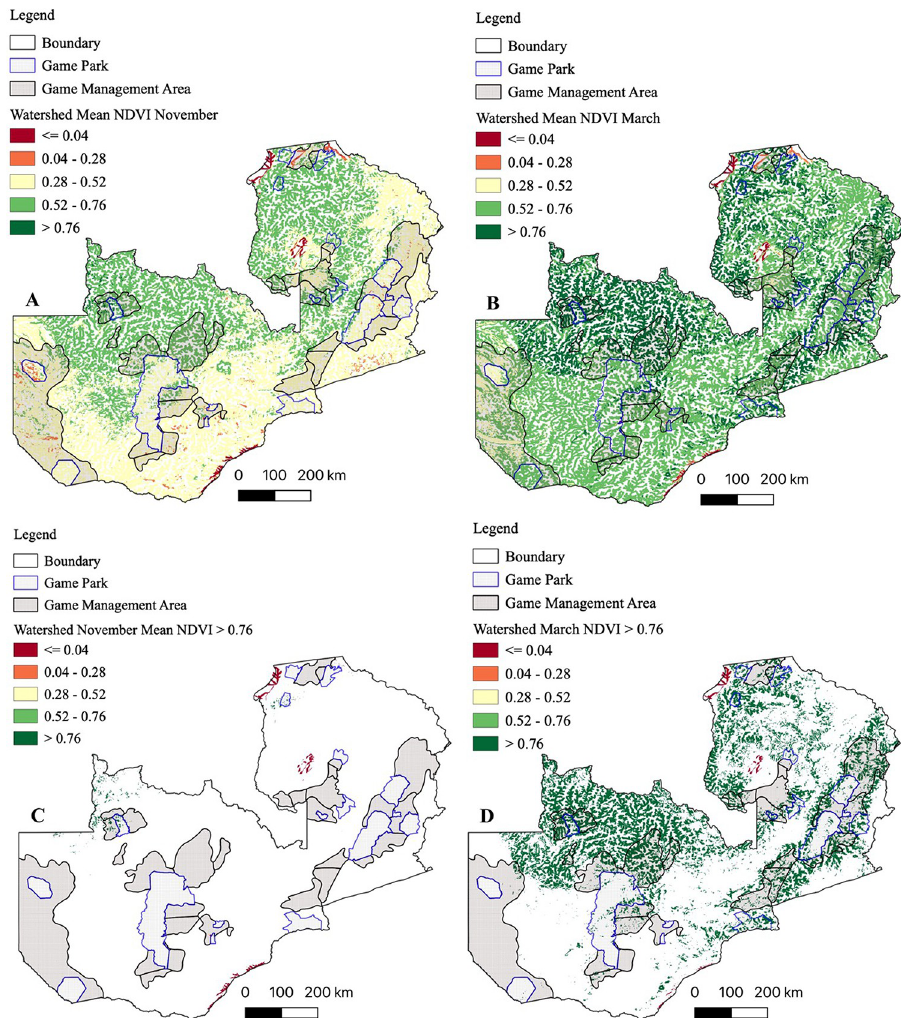
Fig 5. Riparian mean normalized difference vegetation index (NDVI) for the November and March. NDVI were calculated as means for the period 2000–2019. (A) Riparian NDVI for November. (B) Riparian NDVI for March. (C) Riparian NDVI > 0.76 for November showing RVF high risk areas. (D) Riparian NDVI > 0.76 for March showing RVF high risk areas. Shapefile republished from DIVA-GIS database (https://www.diva-gis.org/) under a CC